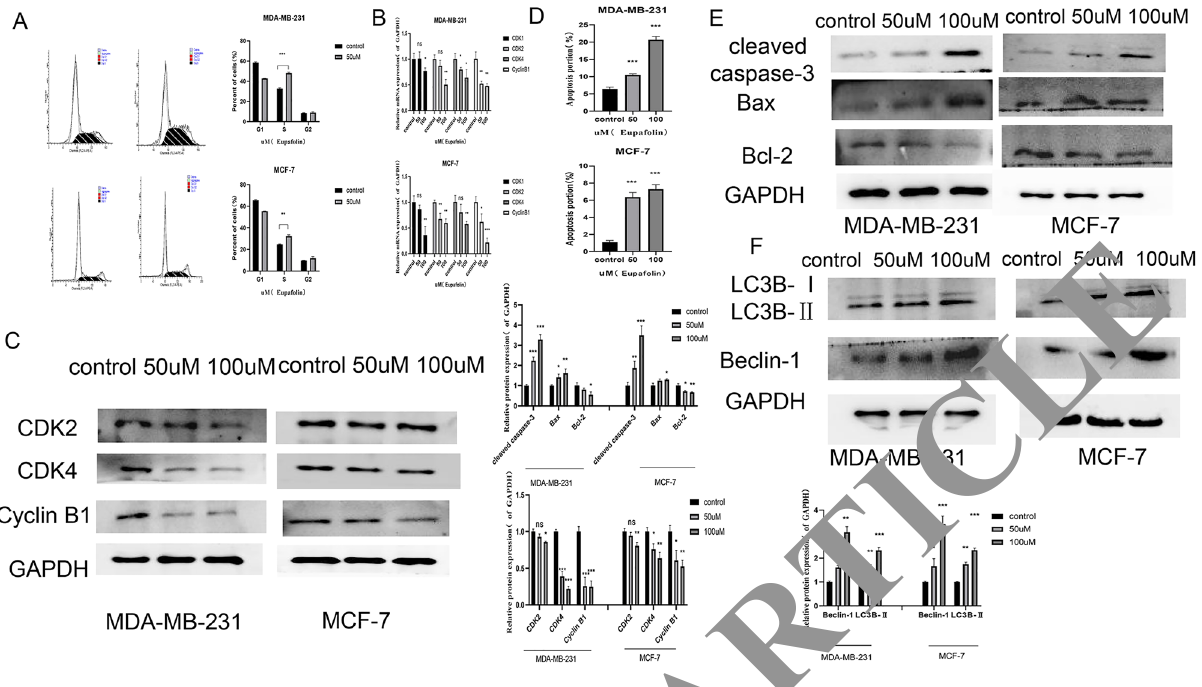
Figure 2. Effect of Eupafolin on the distribution of breast cancer cells in cell cycle phases, apoptosis and autophagy. MDA-MB-231 and MCF-7 cells were incubated with 50 or 100 μM of Eupafolin for 24 h. Next, all cells were collected for further analysis. ( A ) Flow cytometry analysis to determine the effect of Eupafolin on cell cycle arrest. ( B , C ) RT-qPCR and Western Blot analysis for CDK1, CDK2, CDK4 and Cyclin B1. Full-length images are presented in Supplementary Fig. 1. ( D ) Flow cytometry analysis for evaluation of apoptosis. ( E ) Western blot analysis of Bcl-2, cleaved caspase-3 and Bax. Full-length images are presented in Supplementary Fig. 2. ( F ) Western blot analysis of Beclin 1 and LC3-II. Full-length images are presented in Supplementary Fig. 3. Graphs of signal intensity were obtained through band densitometry and referred to GAPDH and control levels. Data are representative of three independent experiments and expressed as mean ± SD. P > 0.05 indicates non-significance; ***P < 0.001; **P < 0.01; *P <